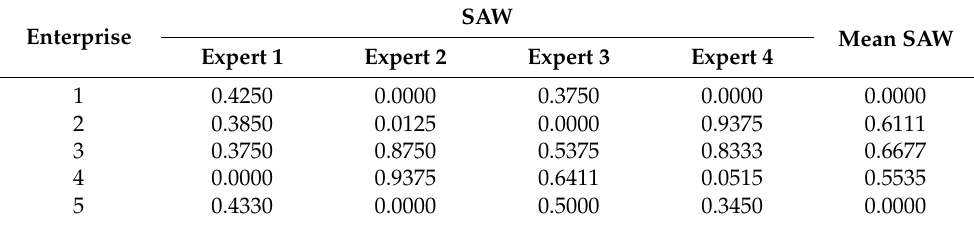
Table 4. Acceptance